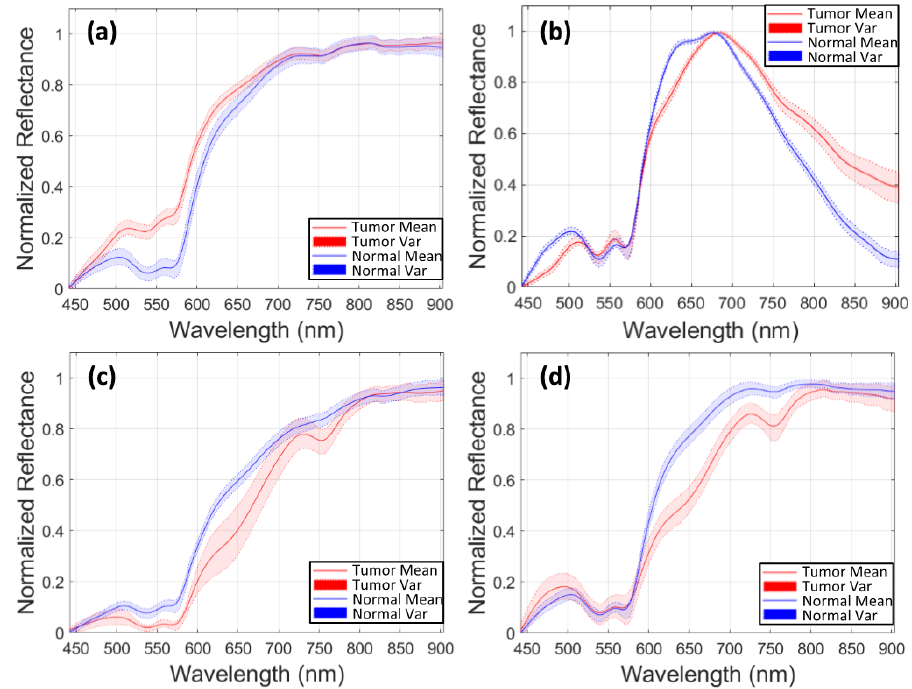
Figure 8. Examples of the different means and variances of the normal (blue) and tumor (red) spectral signatures from different HS images that compose the labeled dataset. ( a ) Data from image 020-01.